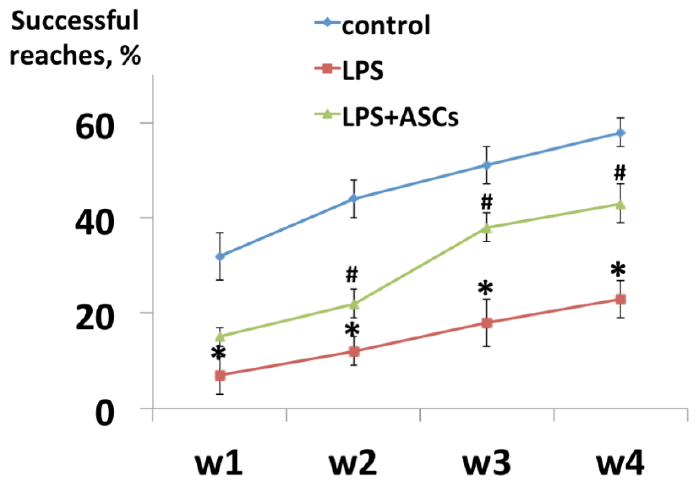
Figure 1. The progression in proficiency in reaching behavior with time in weeks (W). LPS—lipopolysaccharide injected animals (N = 8), ASCs—adipose-derived stem cells treatment (N = 8). *—statistically significant di ff erence compared with control (N = 8) ( p < 0.05). #—statistically significant di ff erence compared with LPS-injected animals ( p < 0.05). N = the number of animals in each experimental group.